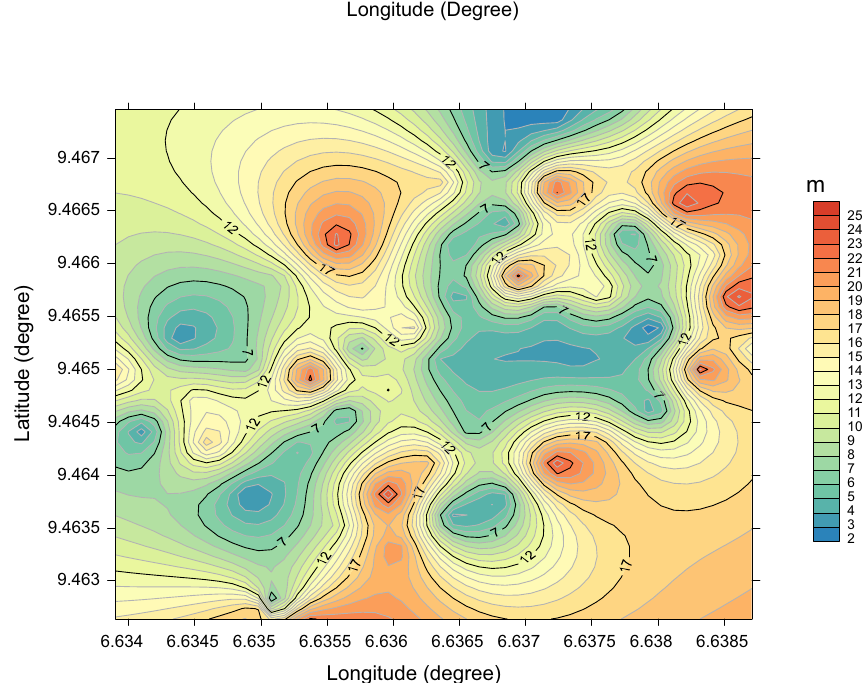
Fig. 9 Isopach map of the